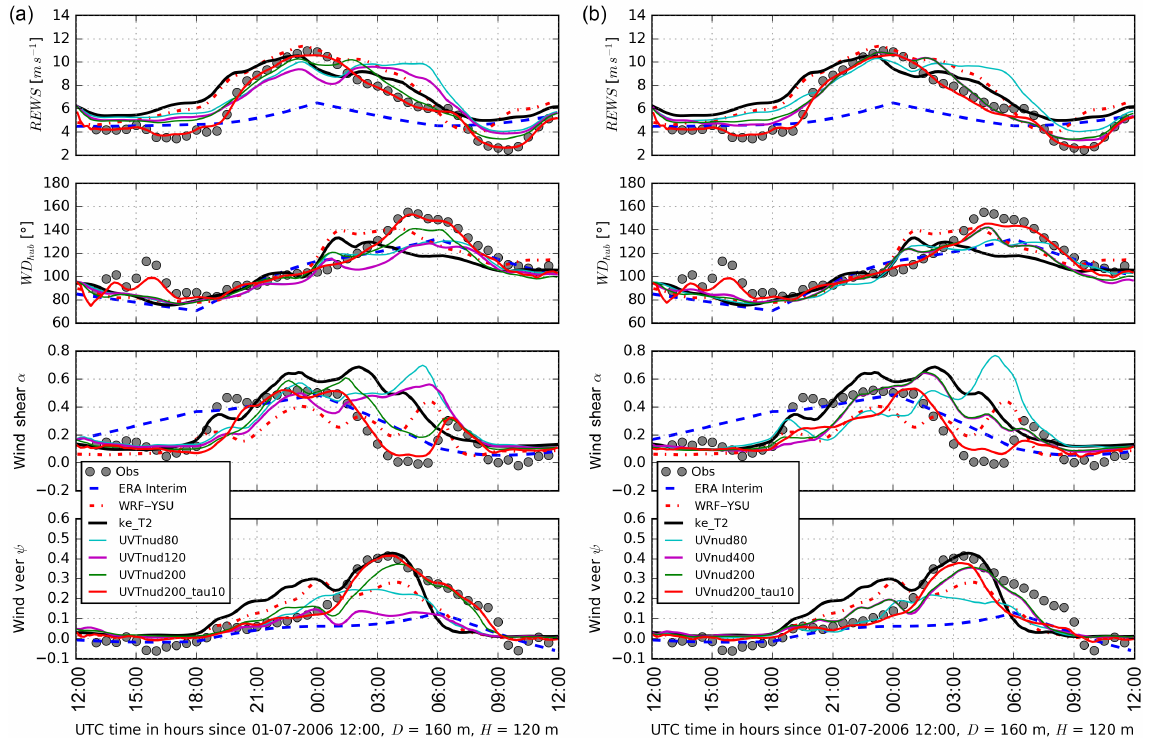
Figure 12. GABLS3 time series of rotor-based quantities of interest from top to bottom: rotor equivalent wind speed REWS, hub-height wind direction WD hub , wind shear α and wind veer ψ . Sensitivity of the k - ε SCM to different nudging strategies, as per Table 1, assimilating wind speed observations “UV” (left), wind speed and air temperature observations “UVT” (right), and comparison with the reference SCM (without nudging, ke_T2), the WRF simulation, the ERA Interim input data and the observations.